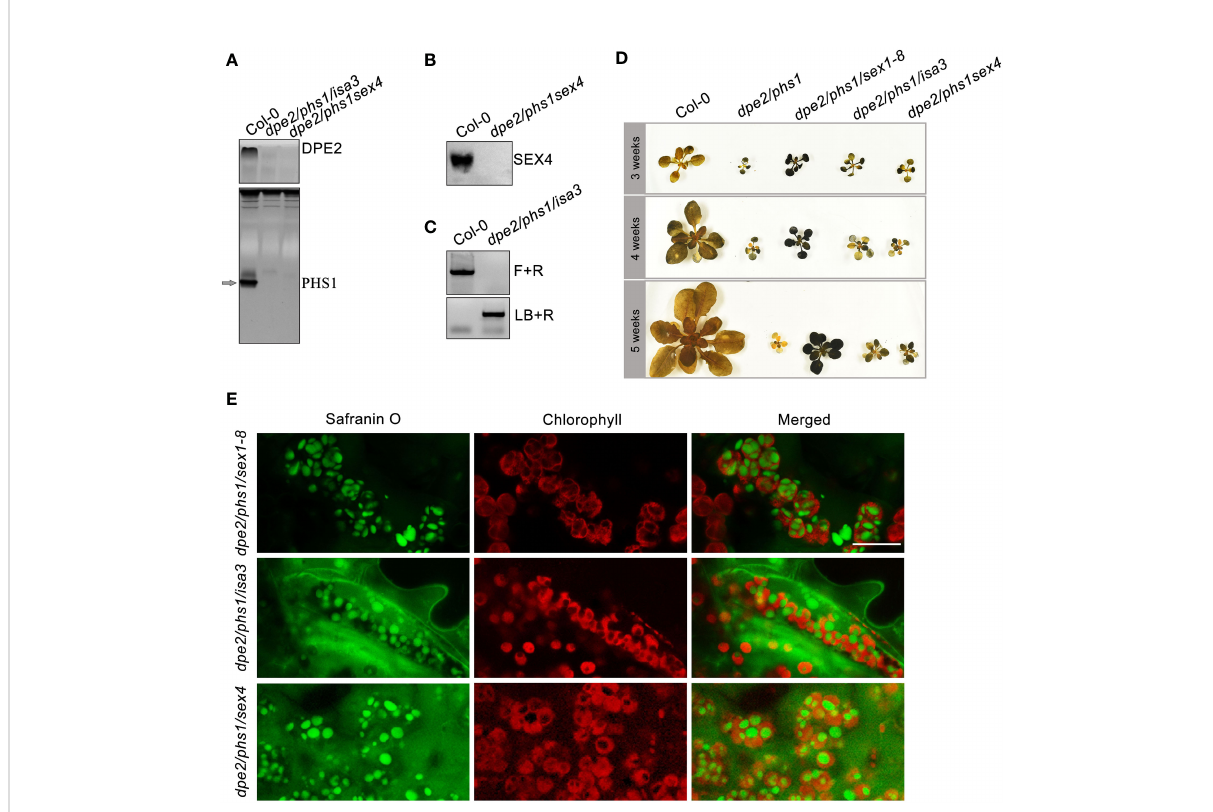
FIGURE 4 The three distinguishable periods observed in dpe2/phs1/sex4 and dpe2/phs1/isa3 grown under light/dark regime: (A) Con fi rmation of the lack of activity of PHS1 and DPE2 by native PAGE. The arrow indicates the position of PHS1; (B) Detection of SEX4 by Western blot and immunodetection. A total of 10 m g protein was loaded per lane for analysis in A and B; (C) T-DNA insertion of ISA3. Forward (F) and Reverse (R) primers were used to check homozygosity. R and LB o8474 (LB) were used to check T-DNA insertion; (D) Semi-quantitative starch determination from the three periods. Shoots were harvested at the end of the light phase at three, four, and fi ve weeks, respectively. (E) LCSM observation of starch granule number per chloroplast in Y of the triple mutants, leaves were taken from 3-week plant as shown in (D) Bar = 10